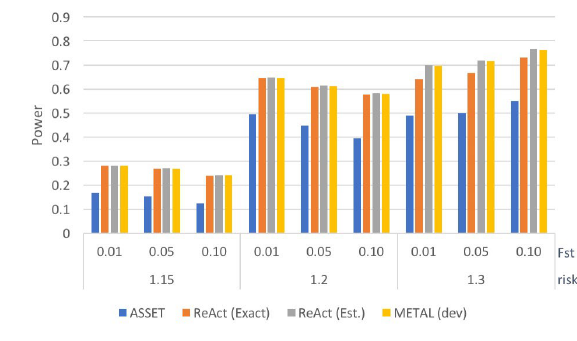
5 10 . METAL dev refers − ·